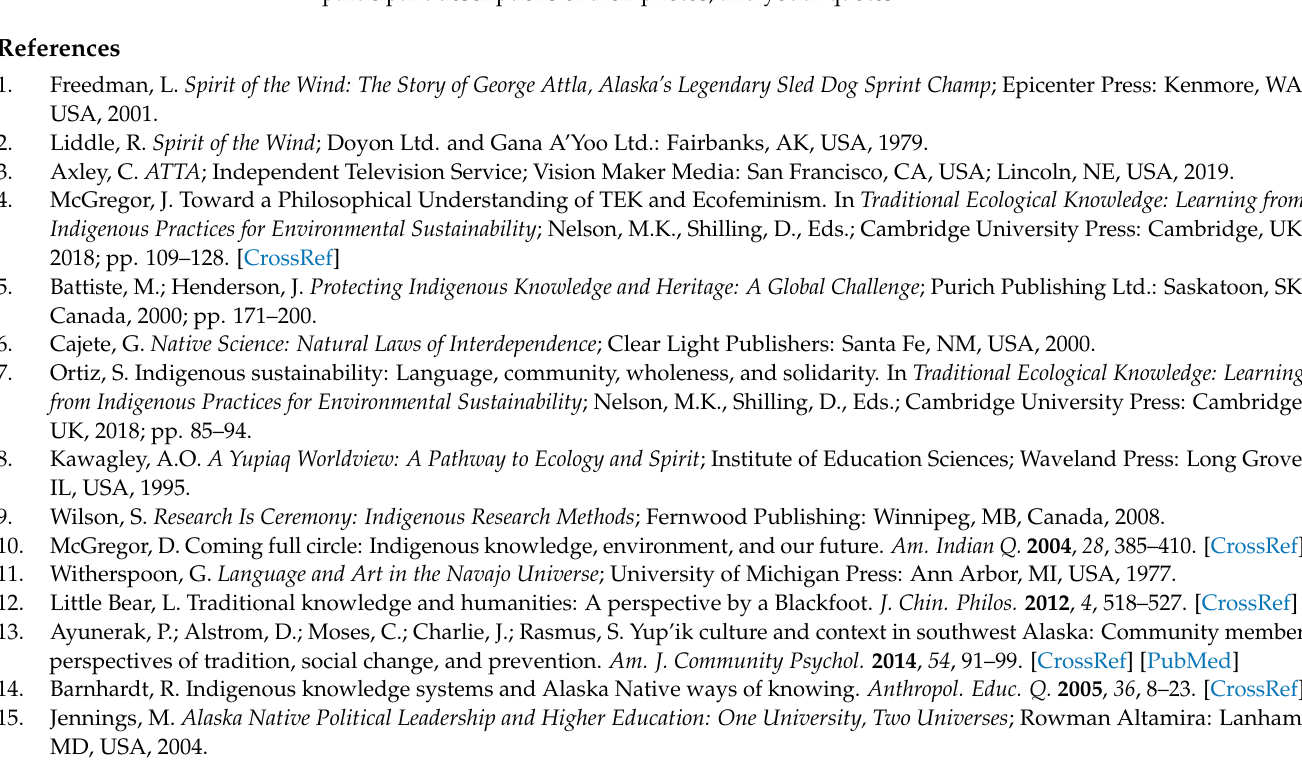
Figure A2. Photovoice themes “Play fun puppies”, “Nature” and “Dog care”, along with youth participant descriptions of their photos, and youth quotes.